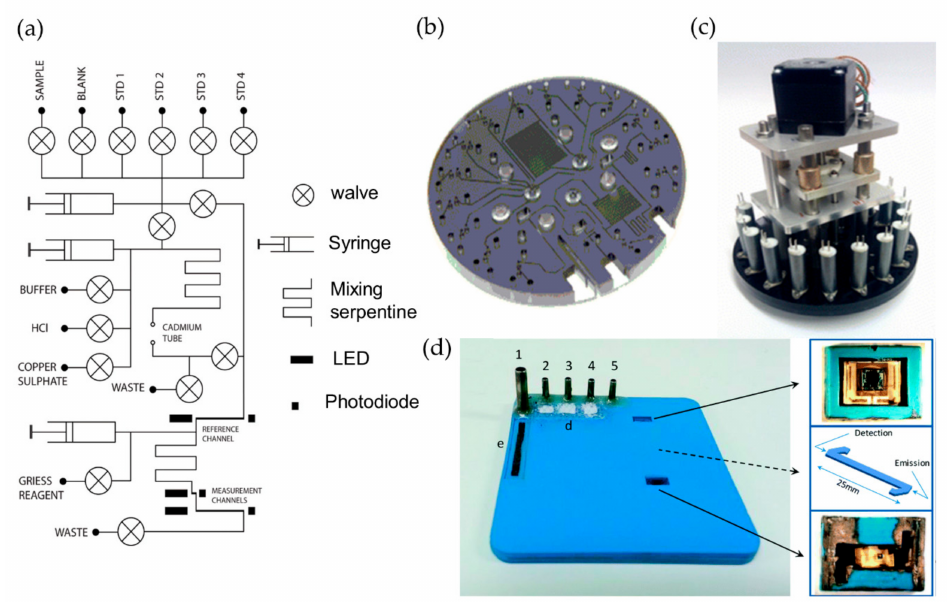
Figure 1. The optofluidic platforms and integrated devices used for the determination of nitrate and nitrite. ( a – c ) are the flow diagram, the corresponding photograph, and autonomous integrated device of the microanalyzer used to determine the total nitrate and nitrite. ( d ) The optofluidic chip and the photographs of the autonomous integrated device designed by Cisneros et al. Images reproduced from